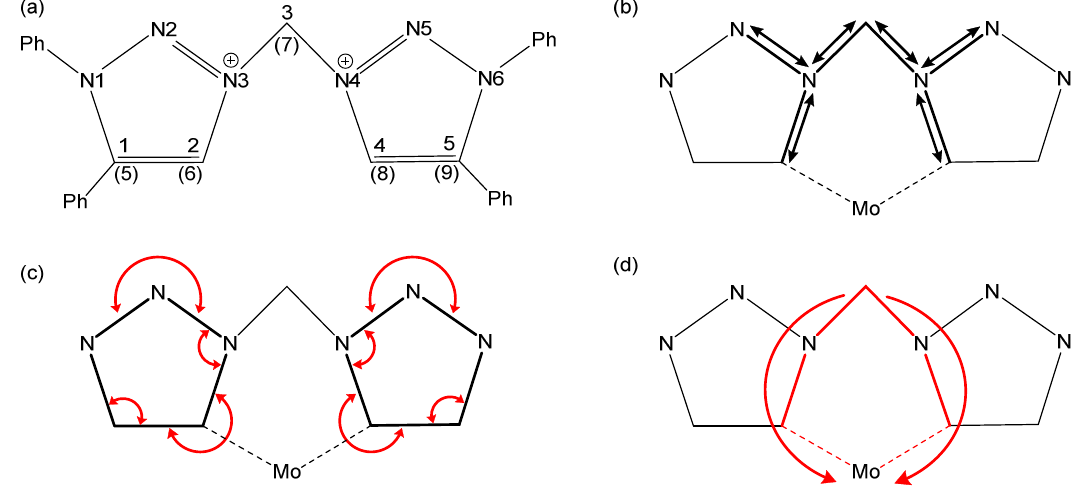
Figure 4. Schematic representation of the observed changes in bond distances (black arrows) and angles (red arrows) of the bistriazolium ( 2 ) and the molybdenum coordinated bistriazolylidene ( 3 ) moieties. ( a ): Labels of the bistriazolium and the coordinated bistriazolylidene (in brackets, where deviating). ( b ): significantly shortened bond lengths after coordination. ( c ): significantly changed angles. ( d ): Changes in the torsion angle in a butterfly kind of motion through coordination with molybdenum.